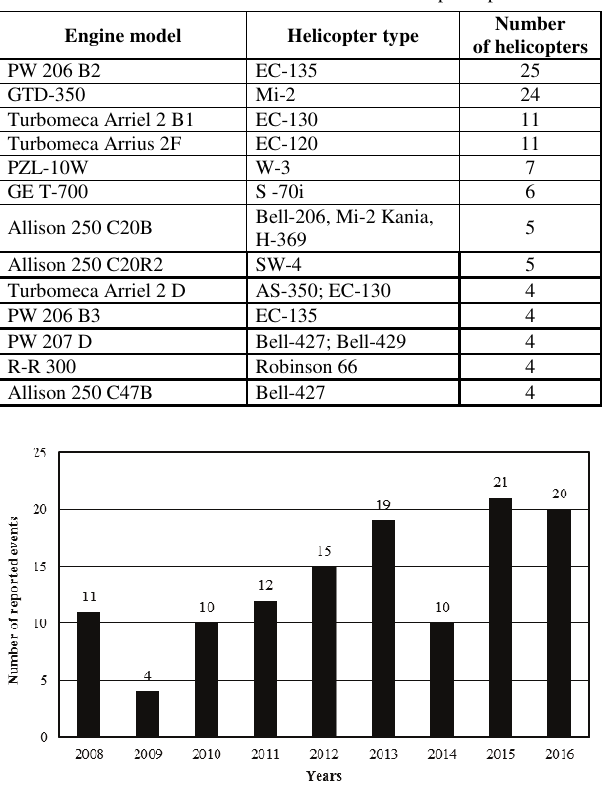
Fig. 18. Number of events caused by turboshaft engines installed on Polish registered aircraft between 2008-2016